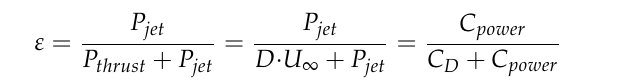
Table 3. Jet power consumption ratios corresponding to the chosen jet momentum